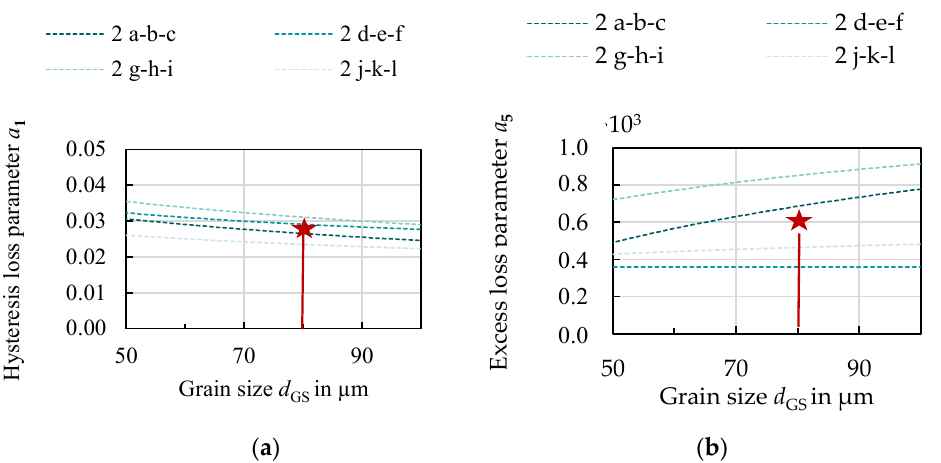
Figure 9. Detail from Figure 8 to determine optimum grain size for a 0.3 mm, Fe–3.2 wt % Si: ( a ) hysteresis loss parameter; ( b ) excess-loss parameter. Table 5. Loss parameters and material parameters for the tailor-made material design approach.